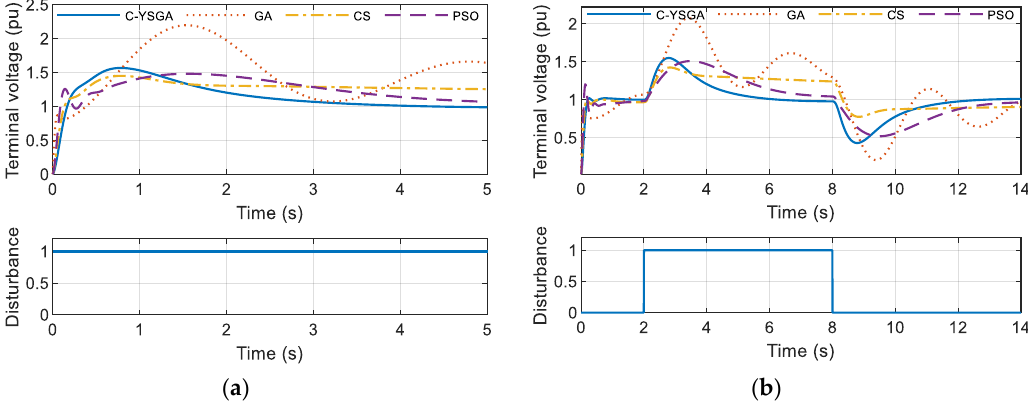
Figure 18. Step responses in the two different cases of the control signal disturbance. ( a ) constant signal, ( b ) step signal that lasts from t = 2 s to t = 8 s.